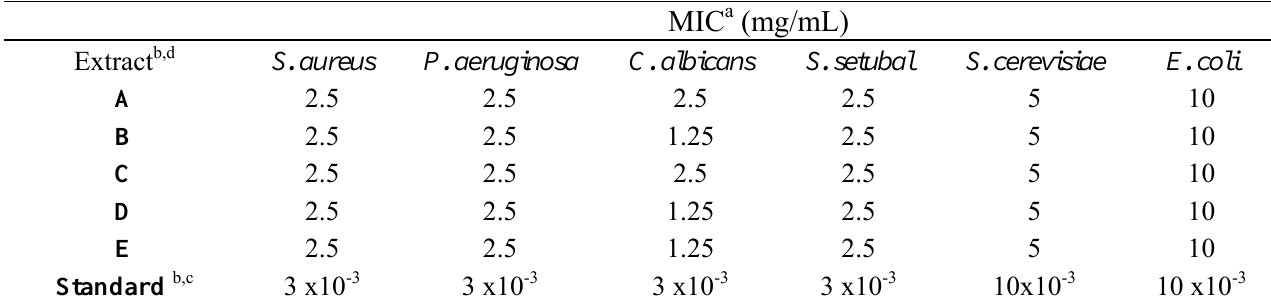
Table 5. Antimicrobial activity of the methanolic extracts ( A - E ) of Eriocaulaceae